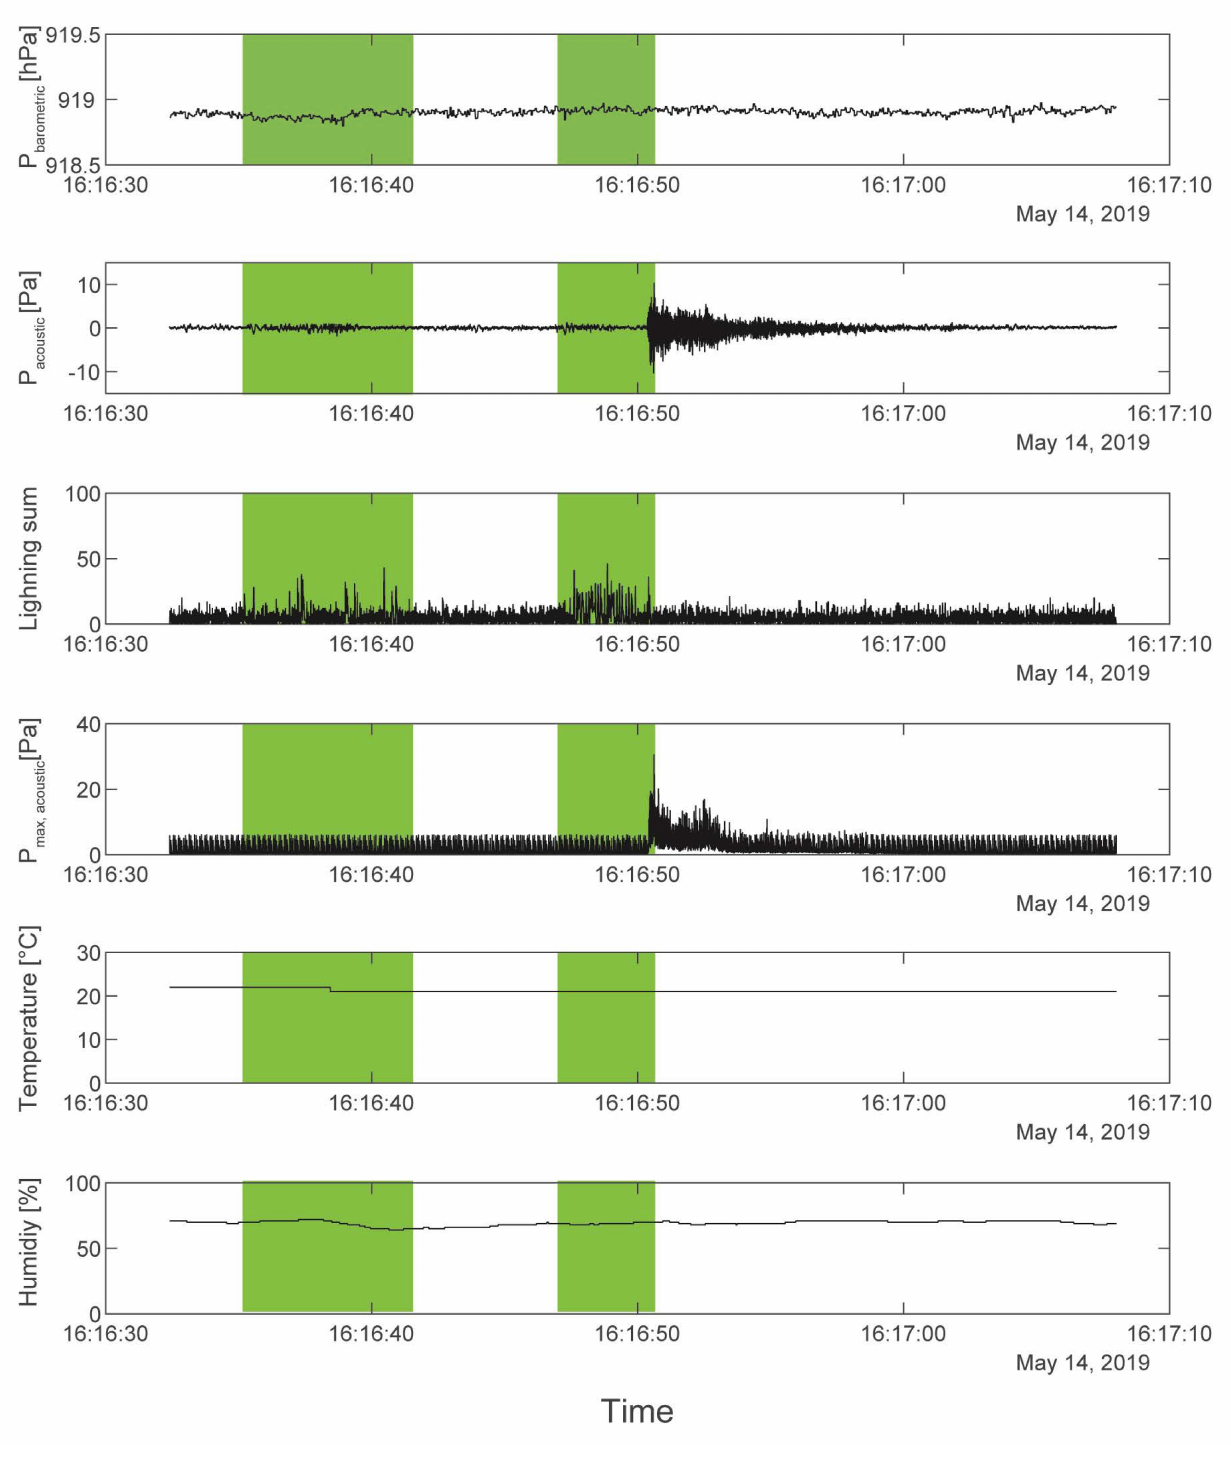
Figure 3: Dataset recorded by sensor 14 during an explosive event on 14 May 2019 at 16:16 UTC at a distance of 136 m from the vent. This plot shows the barometric pressure, acoustic pressure, lightning sum, maximum acoustic pressure, temperature and relative humidity. Areas with green background indicate periods with electrical activity. Refer to Figure 4A and B for the acoustic signals of all operational